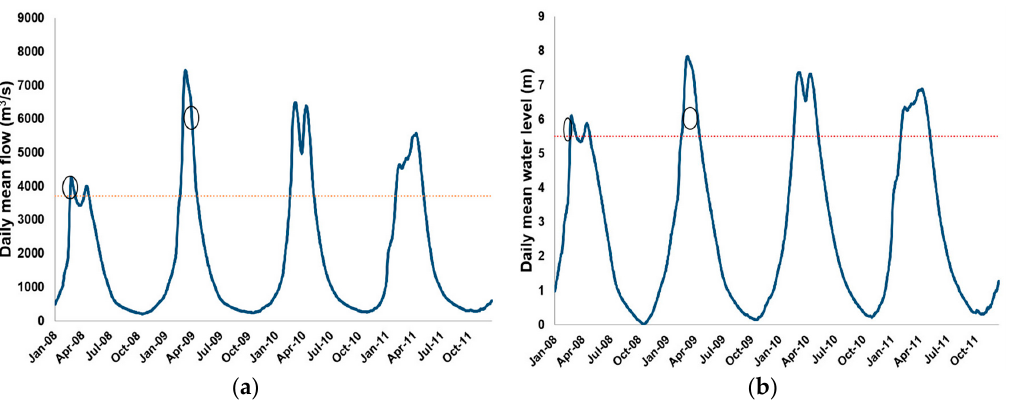
Figure 2. Yearly cycle of Zambezi river: ( a ) Discharge hydrograph; and ( b ) Water level for the period from 2008 to 2011. The dotted line shows the flood threshold whereas the black circles point out the flooding events considered in this study.